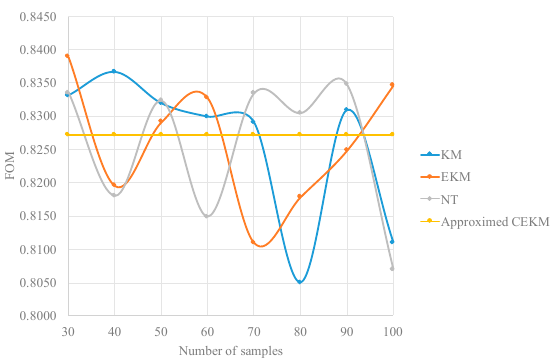
Figure 15. FOM comparison for different type-reduction methods.